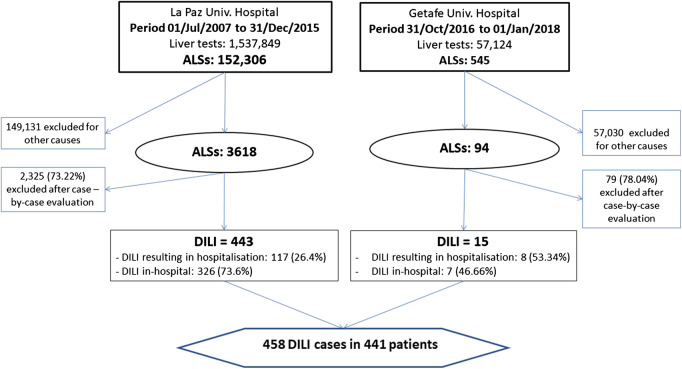
Flowchart of drug-induced liver injury cases detection. Abbreviations: ALSs, automatic laboratory signals.